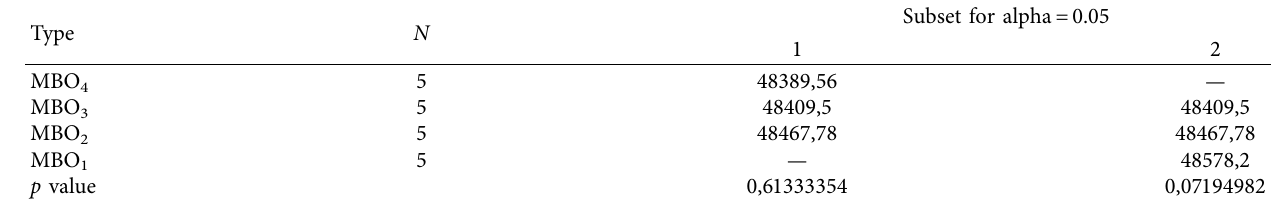
Table 11: Tukey’s test for the pr299 instance.